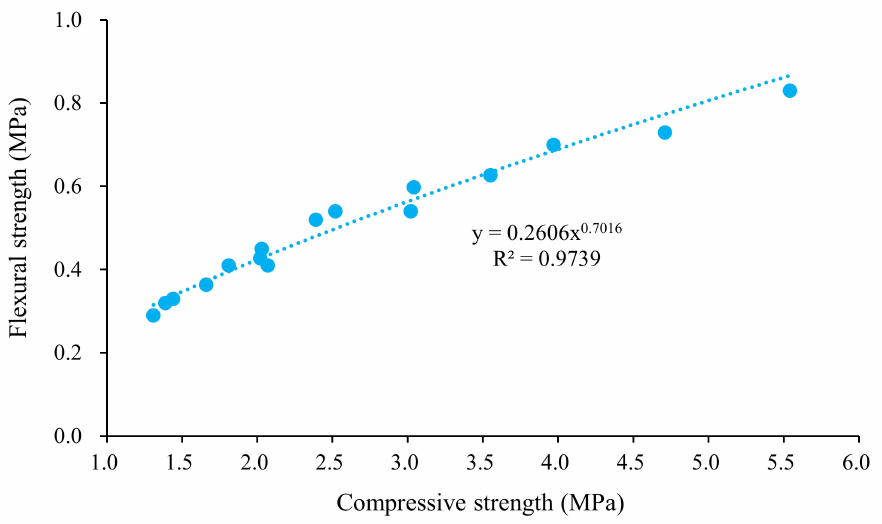
Figure 6. Relationship between flexural and compressive strength of the